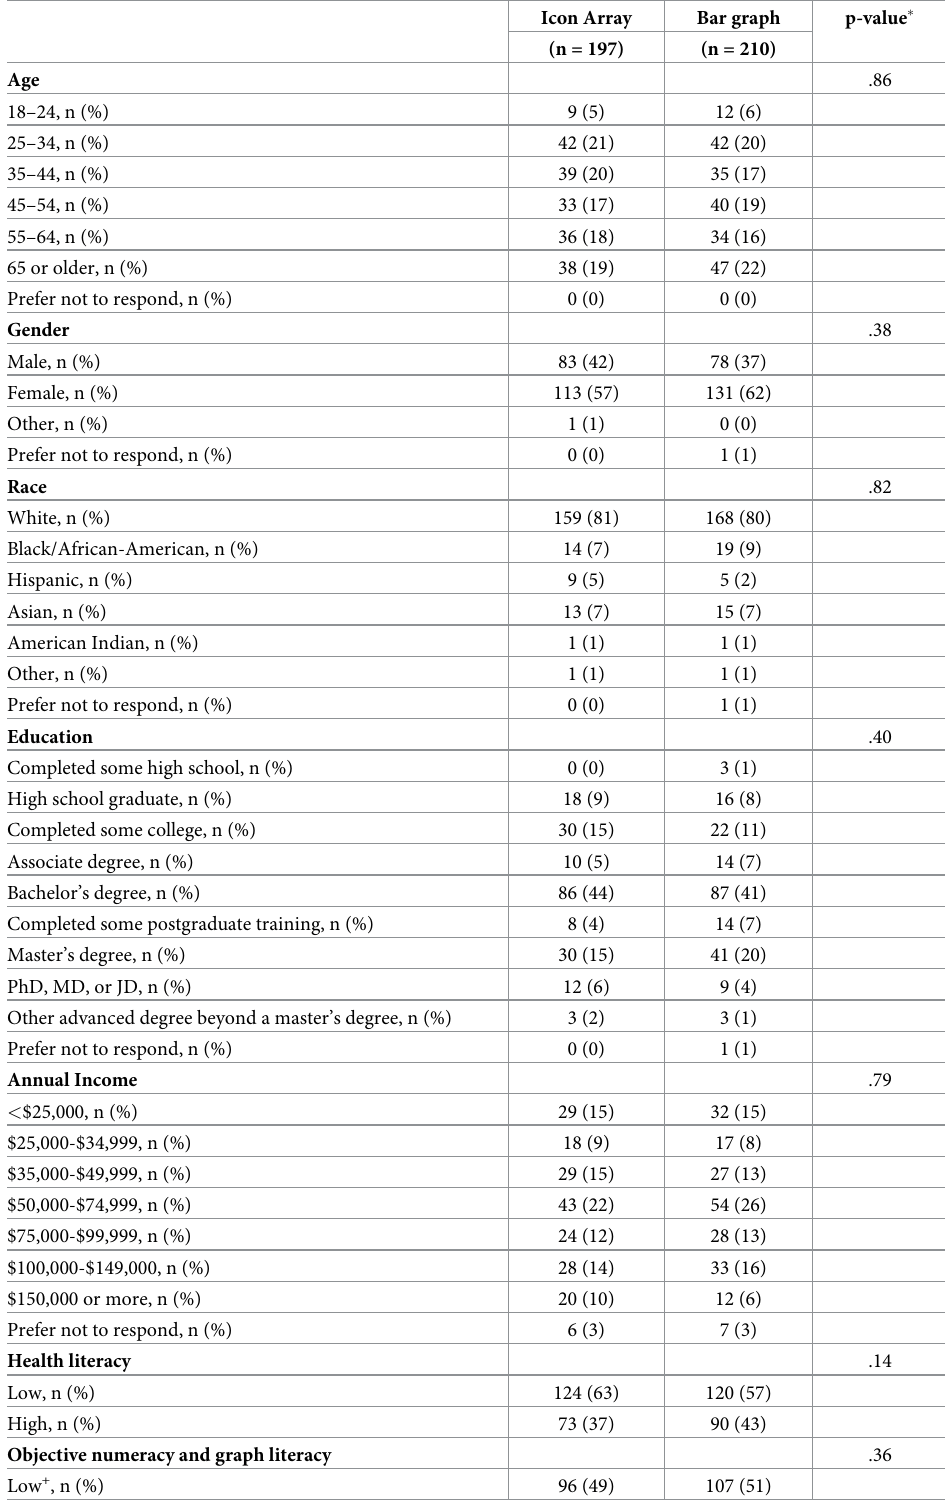
Table 2. Baseline